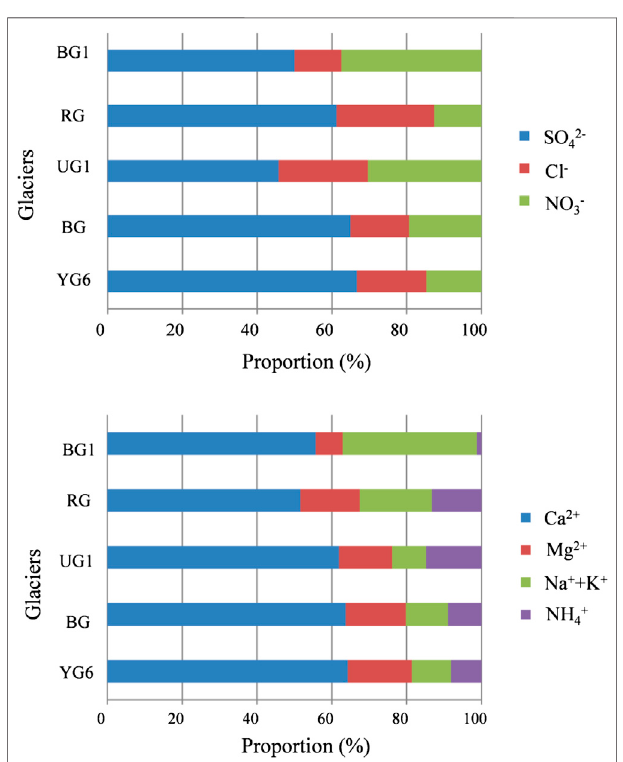
FIGURE 7 | Proportions of major ions in snow pits at various glaciers. YG6, Yushugou Glacier No. 6; BG, Belukha Glacier; UG1, Urumqi Glacier No. 1; RG, Rongbuk Glacier; BG1, Baishui Glacier No.